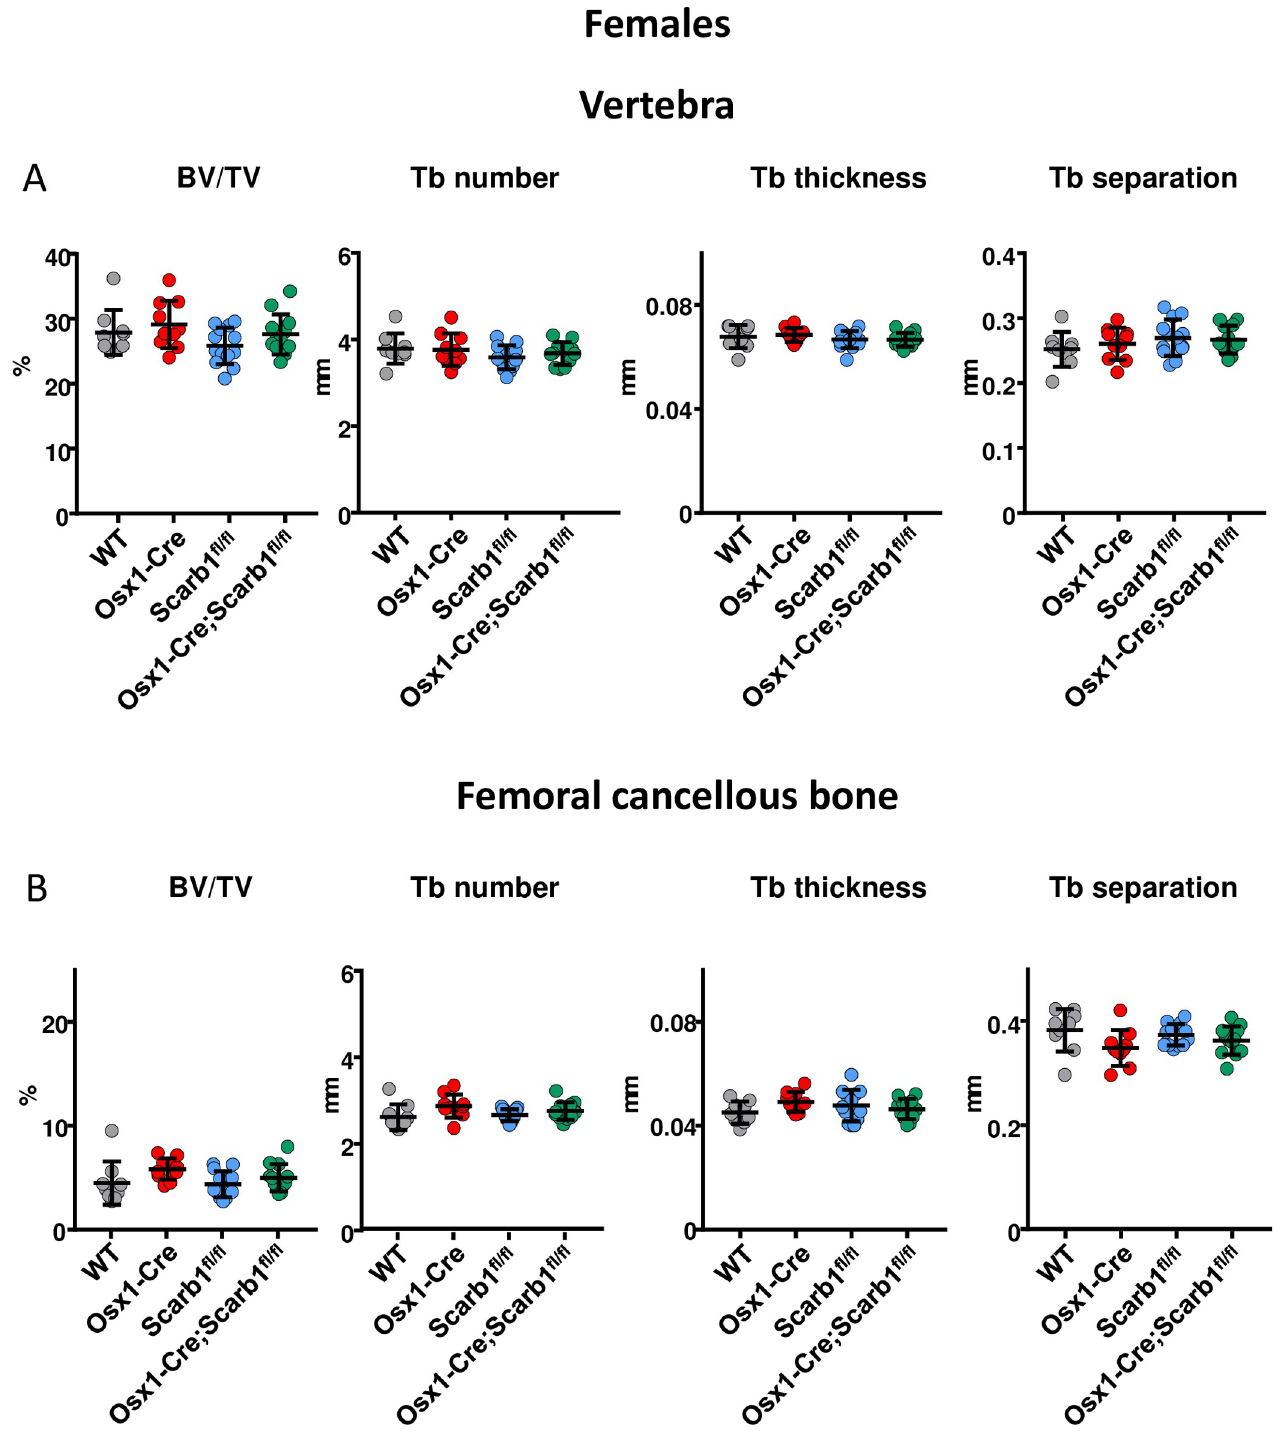
Fig 5. Deletion of Scarb1 in Osx1-Cre expressing cells does not affect trabecular bone in female mice. Micro-CT determination of trabecular bone architecture in 6-month-old female mice in the (A) vertebra and (B) femoral metaphysis [WT n = 9; Osx1-Cre n = 10; Scarb1 fl/fl n = 13; Osx1-Cre;Scarb1 fl/fl n = 12]. Data are shown as mean and standard deviation. Data analyzed by ANOVA, the p-values were adjusted using the Tukey’s pairwise comparison procedure. BV/TV, bone volume /total volume. Tb, trabecular.